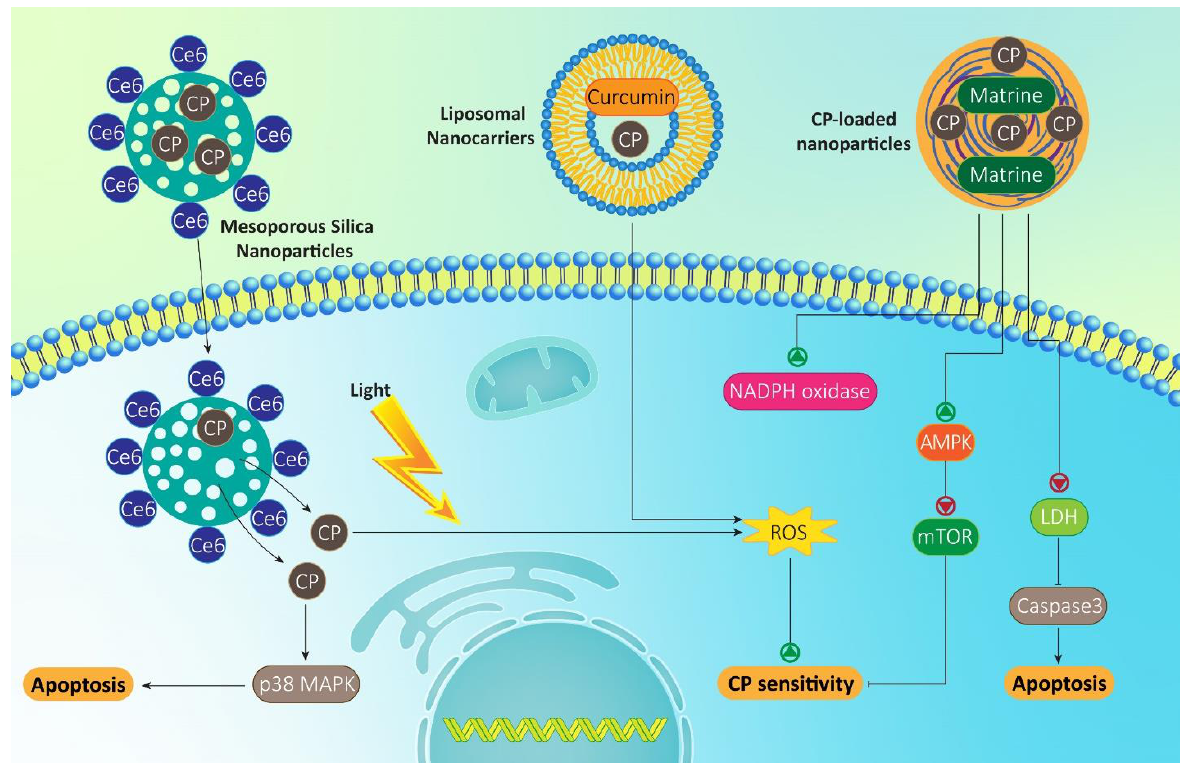
Figure 4. Nanoscale delivery systems in ROS regulating and CP sensitivity. Nanoparticles enhance penetration of CP through cell membrane and via increasing intracellular accumulation, promote its potential in ROS overgeneration and cancer cell death. Anti-tumor compounds such as curcumin and matrine can be co-delivered by CP in effective cancer suppression. Furthermore, phototherapy mediated by nanoparticles enhances CP sensitivity of cancer cells.